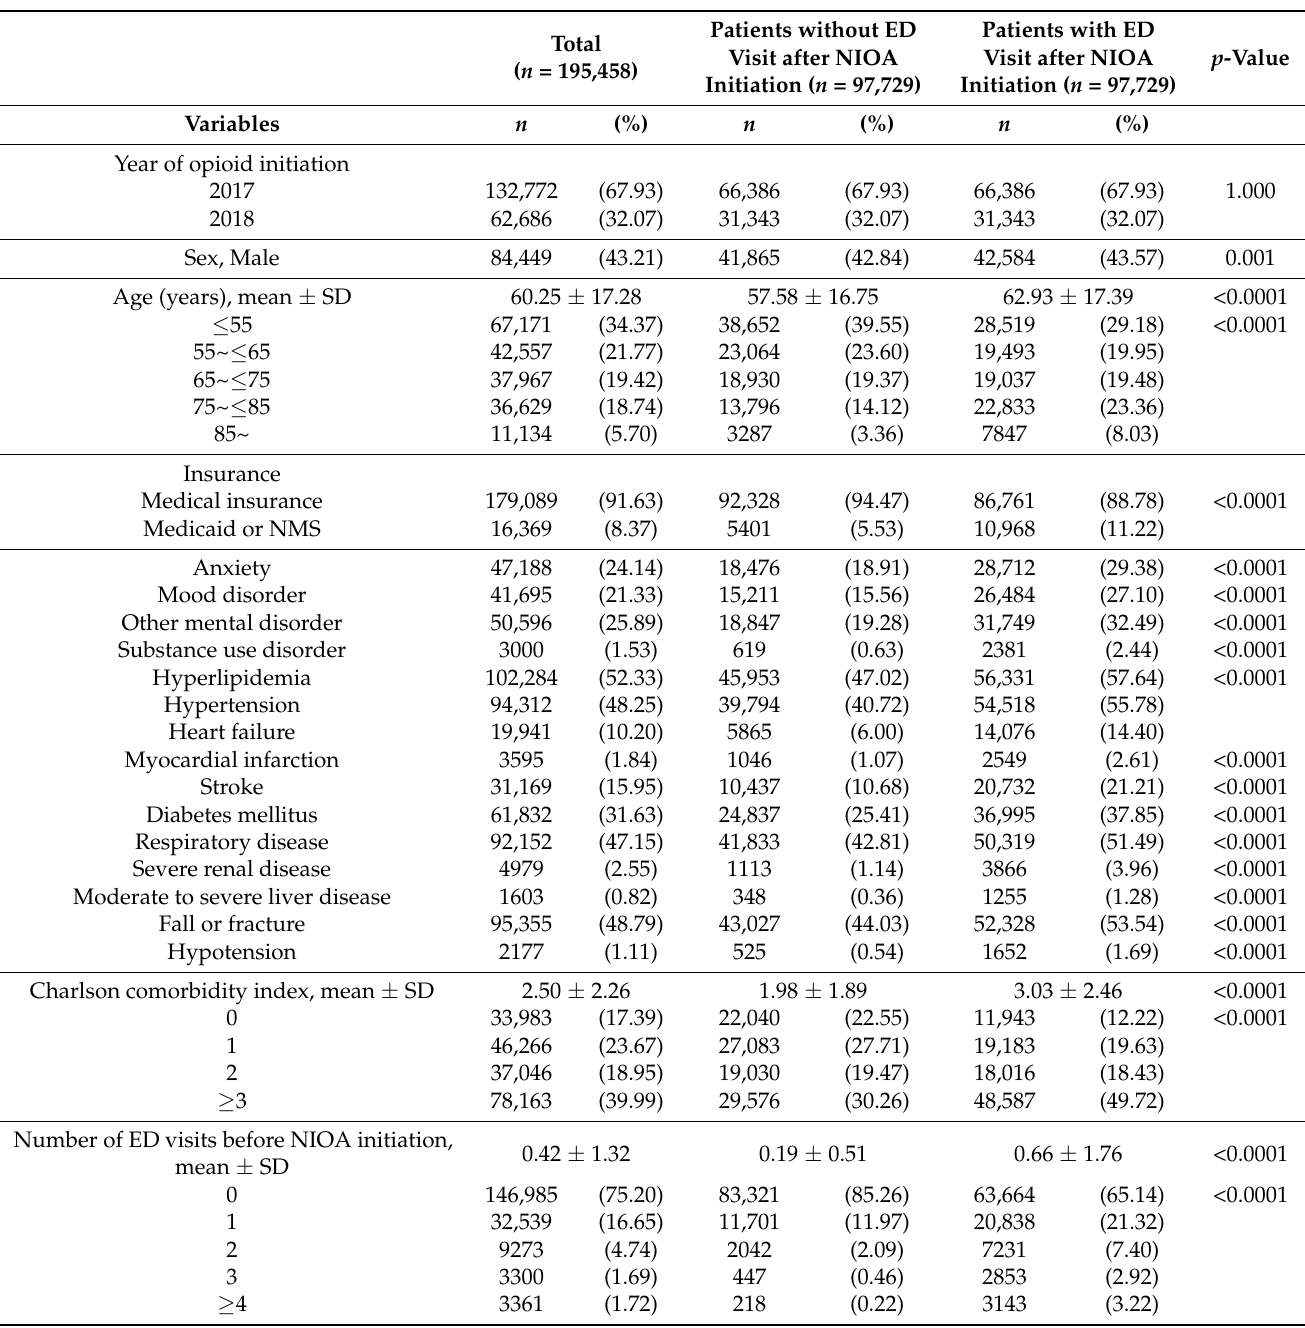
Table 1. Baseline characteristics of the patients who were initially prescribed NIOA for non- cancer pain. Patients with ED Patients without ED Total Visit after NIOA p Visit after NIOA ( n = 195,458) Initiation ( n = 97,729)